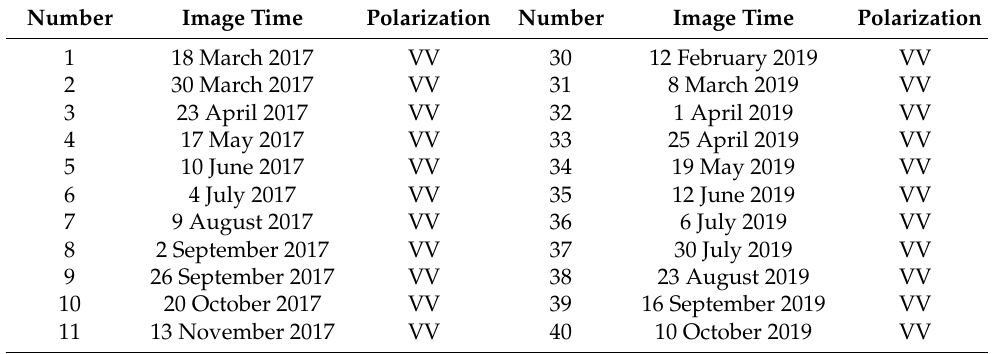
Table 2. Sentinel-1 A image